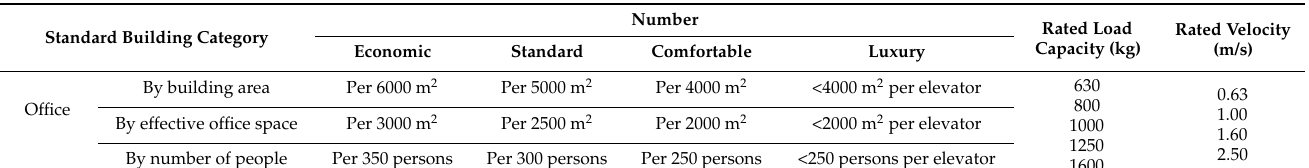
Table 5. The number of elevators and main technical parameters (Office Building Design Standards JGJ/T 67-2019).